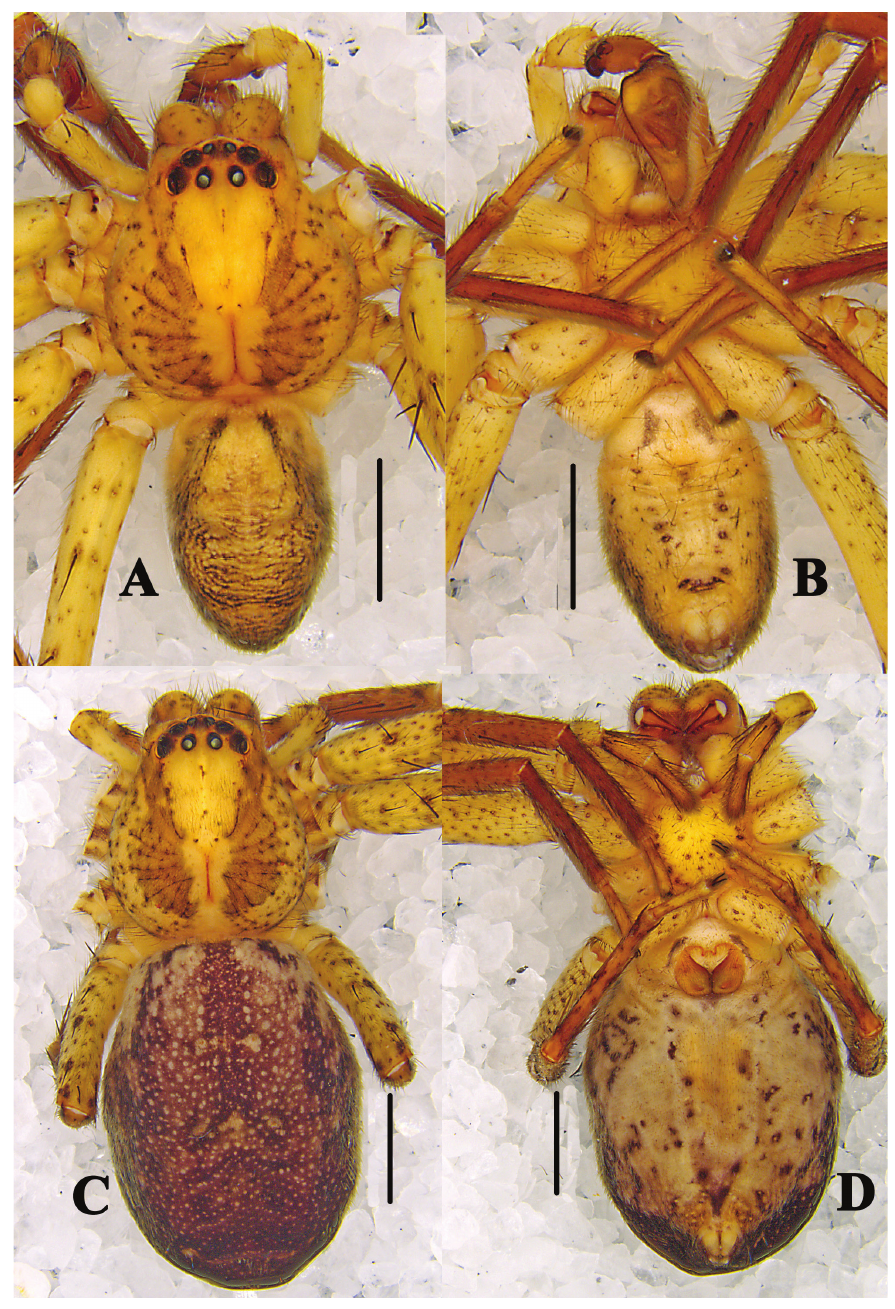
Figure 17. Pseudopoda yunnanensis Yang & Hu, 2001 A, B male habitus ( A dorsal B ventral) C, D female habitus ( C dorsal D ventral). Scale bars: 2